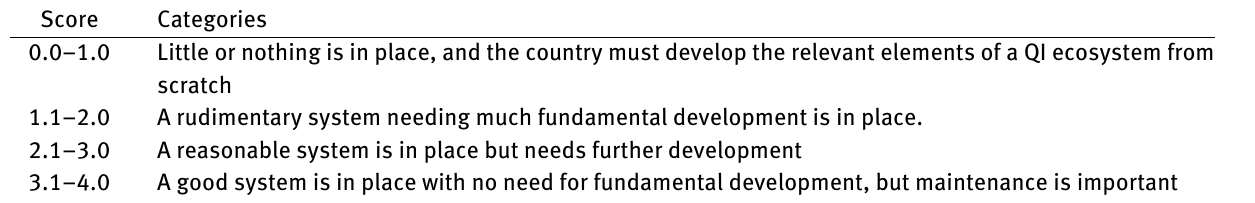
Table 4: Score categories of comprehensive diagnostic condition of quality infrastructure